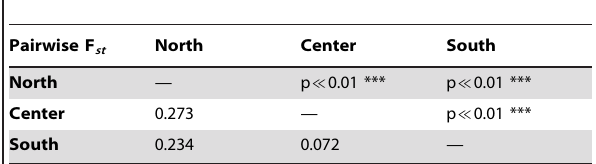
Table 3. Pairwise F st